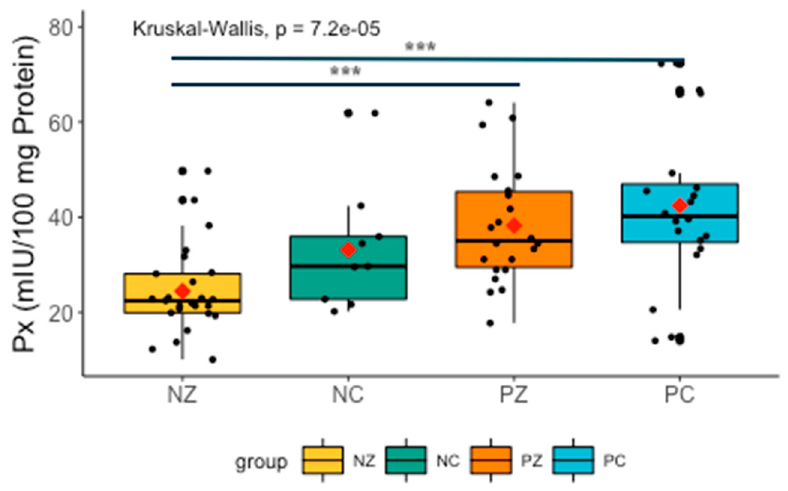
Figure 4. Activity of Px in the examined groups. Px, salivary peroxidase; NZ, generally healthy patients without the BRCA1 mutation; NC, patients with breast cancer but without the BRCA1 mutation; PZ, generally healthy patients with the BRCA1 mutation; PC, patients with both breast cancer and the BRCA1 mutation. *** p < 0.001.